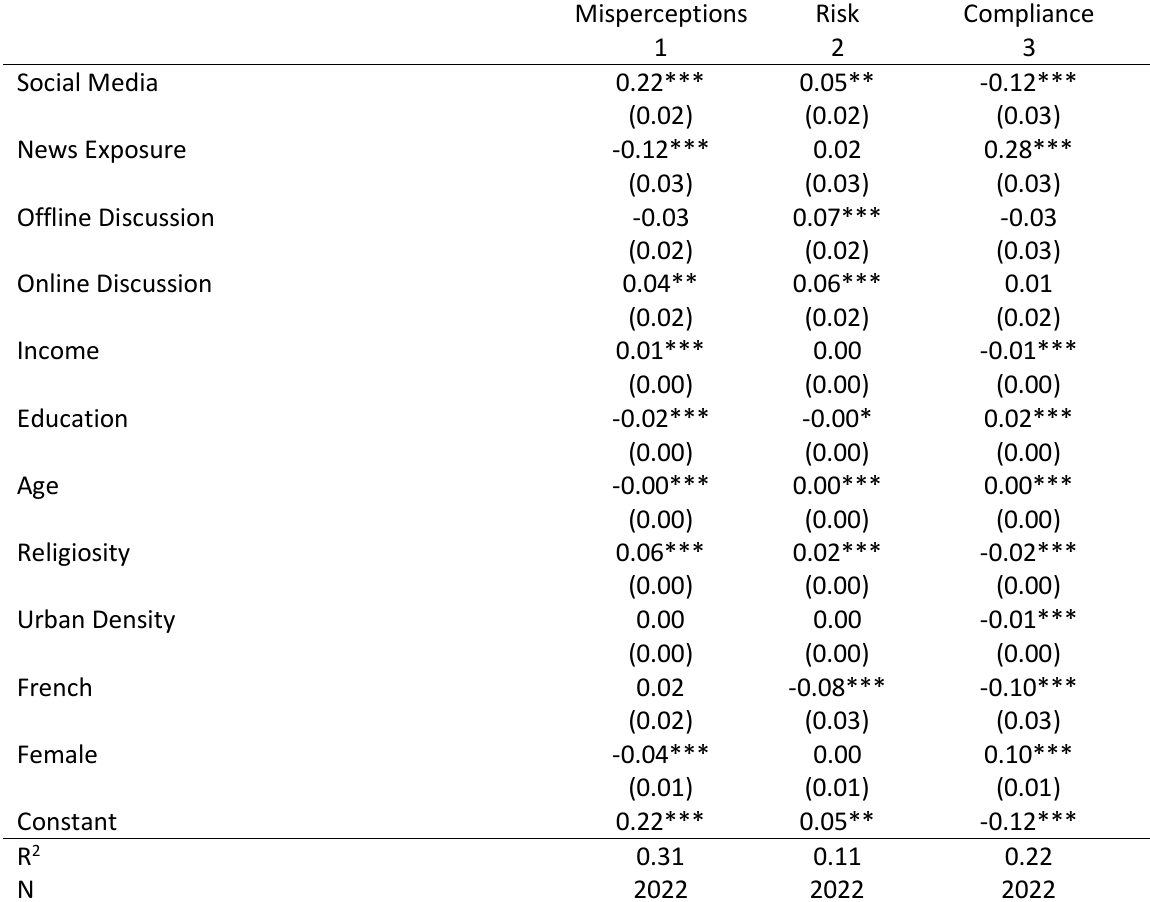
Table A3. OLS Estimates for Figure